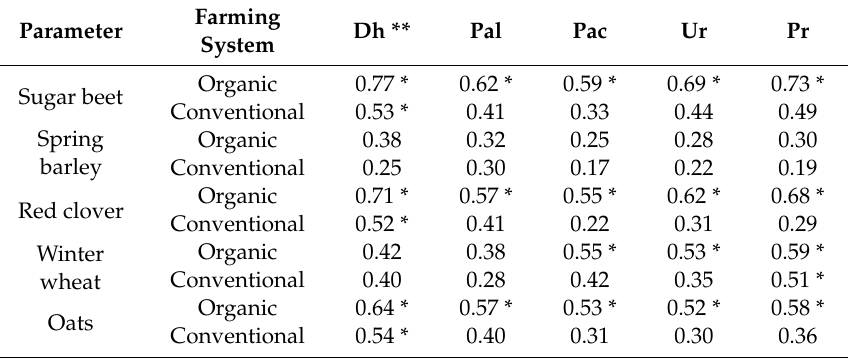
Table 8. Correlation coe ffi cients (r) between the plant species grown under organic and conventional systems and enzymatic